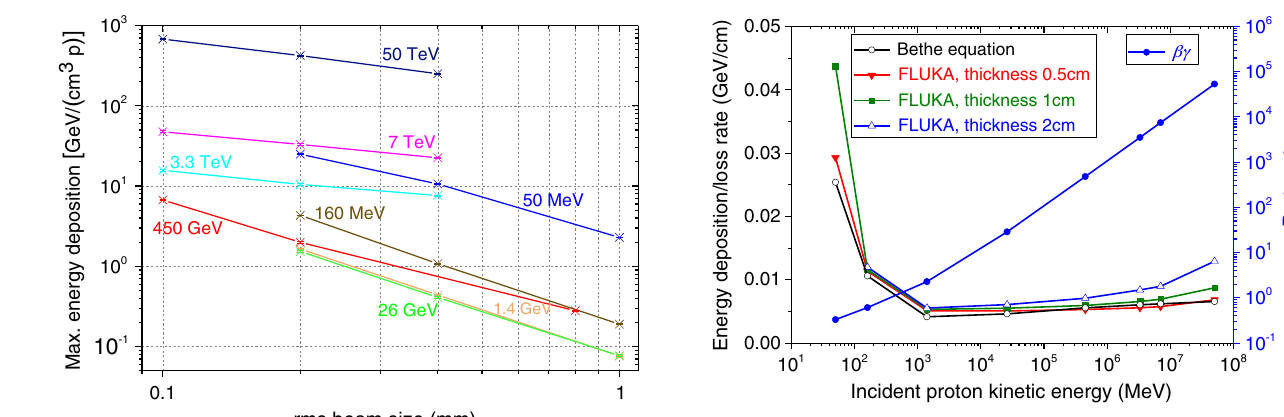
FIG. 17. Maximum energy deposition in graphite as a function of the beam size for the energies from 50 MeV to 50 TeV.